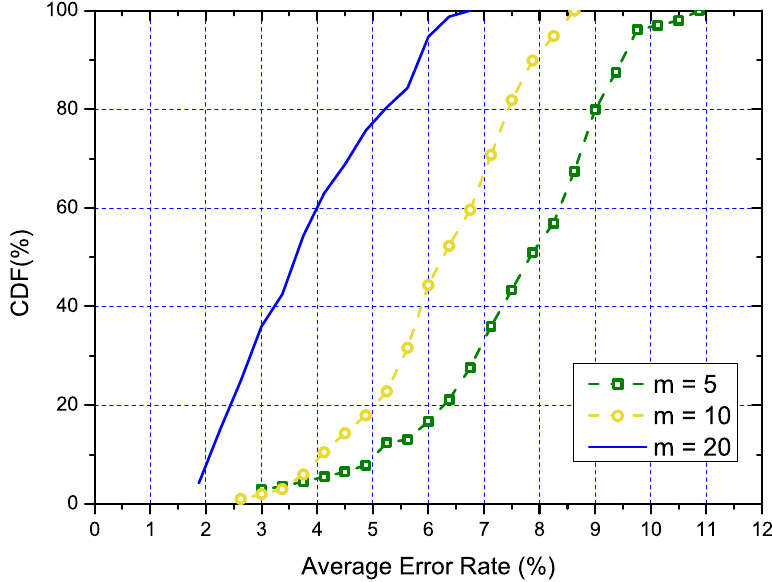
Figure 8. The CDF of the estimated error rate for different numbers of